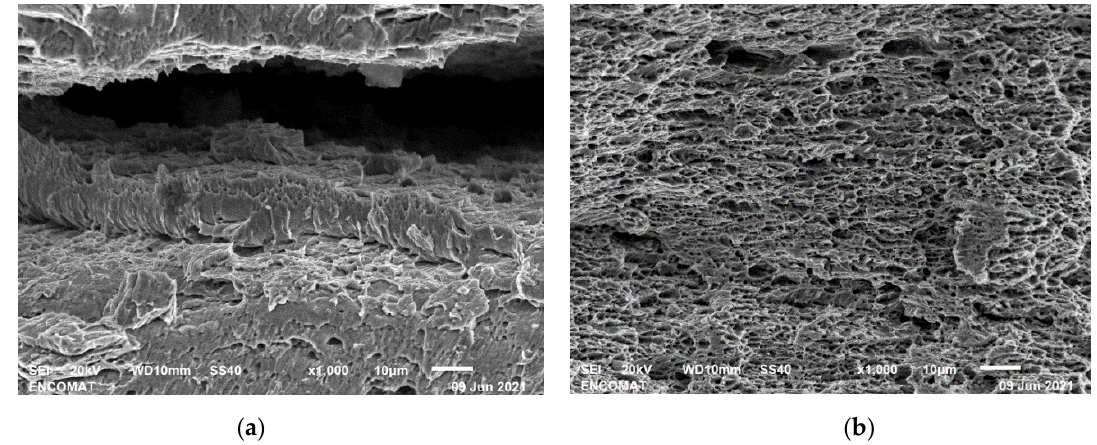
Figure 3. Central crack fracture: ( a ) the fracture lip; ( b ) the presence of micro-voids.